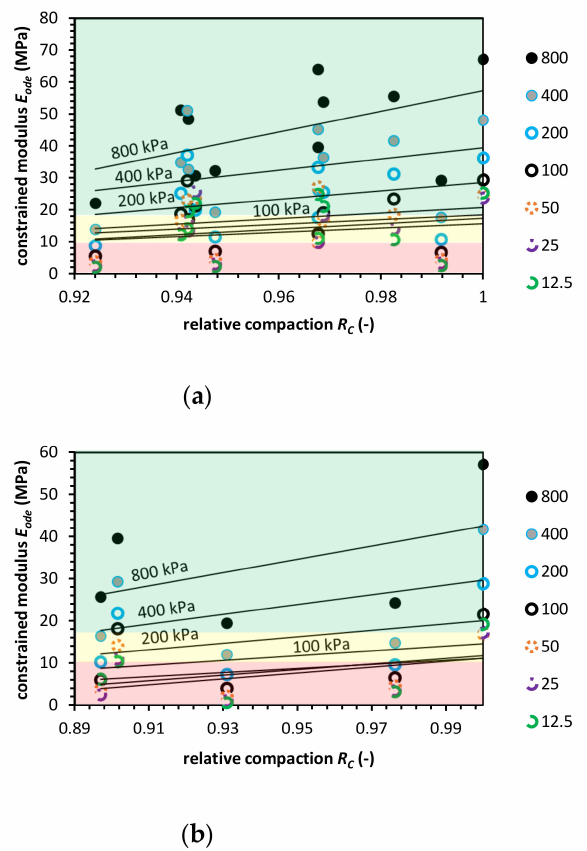
Figure 7. Constrained modulus value versus relative compaction value for fly ash and bottom slag (FA + BS) for: ( a ) the Proctor compaction and ( b ) the Vibro compaction method. Colored areas mean required constrained modulus value, colors indication: green-zone of fulfilled E ode modulus requirement; yellow-moderate zone, where the constrained modulus is in the range of requirements; red-zone in which the E ode do not meet pipe fill